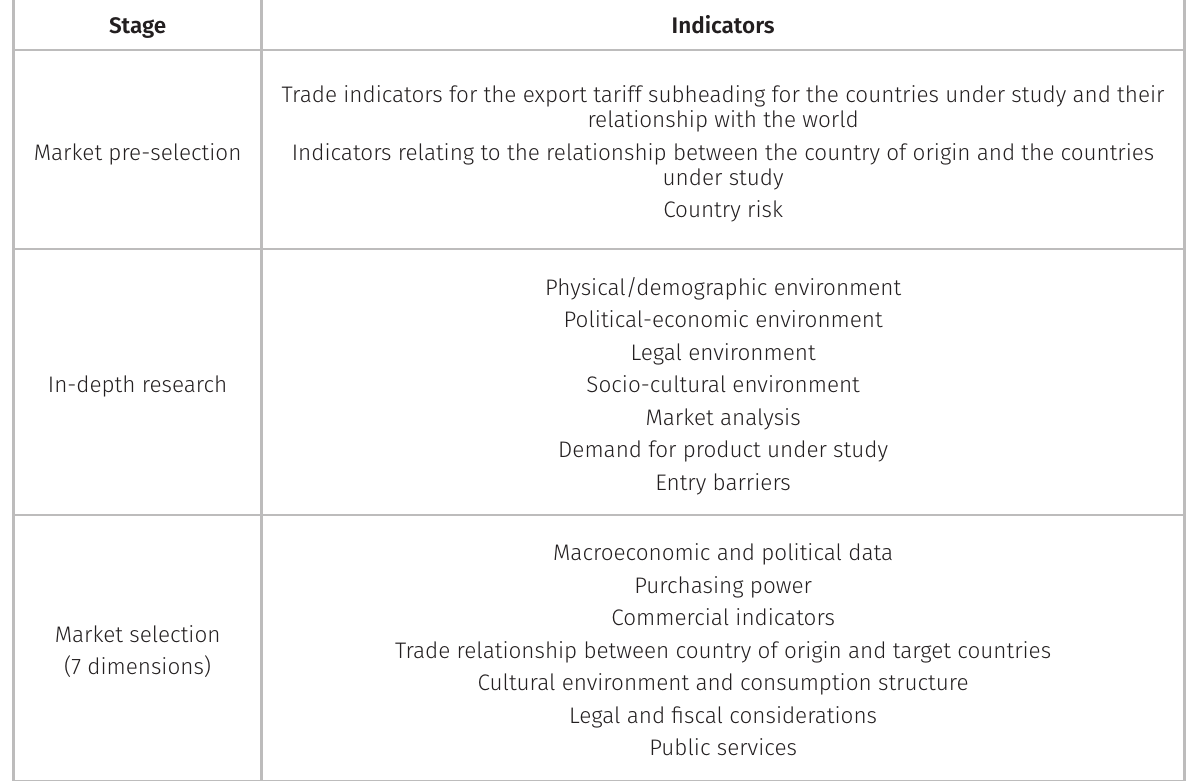
Table III. Stages and indicators of the market selection